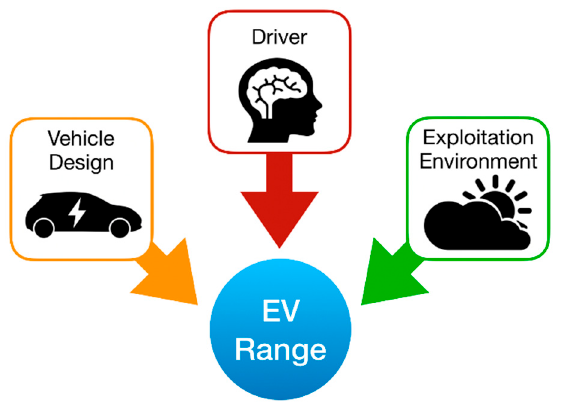
Figure 1. Classes of factors that influence an electric vehicle’s (EV’s) range.